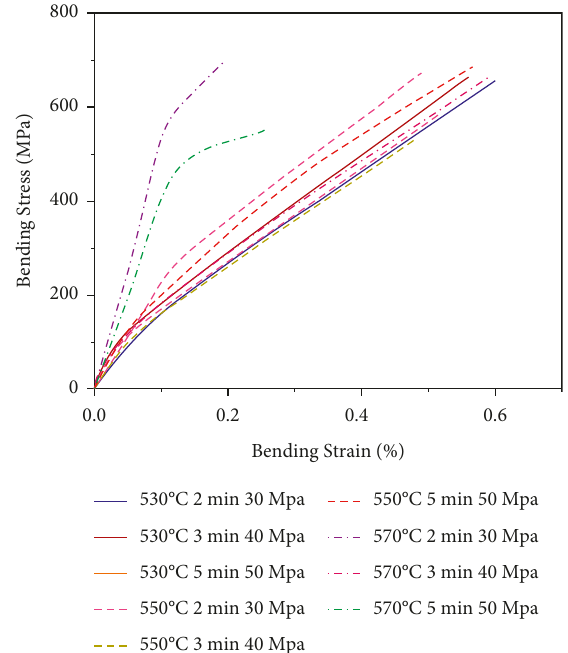
Figure 1: Bending curves of the 50 percent WC/Al 2025 composites made by Spark plasma sintering through variant conditions.